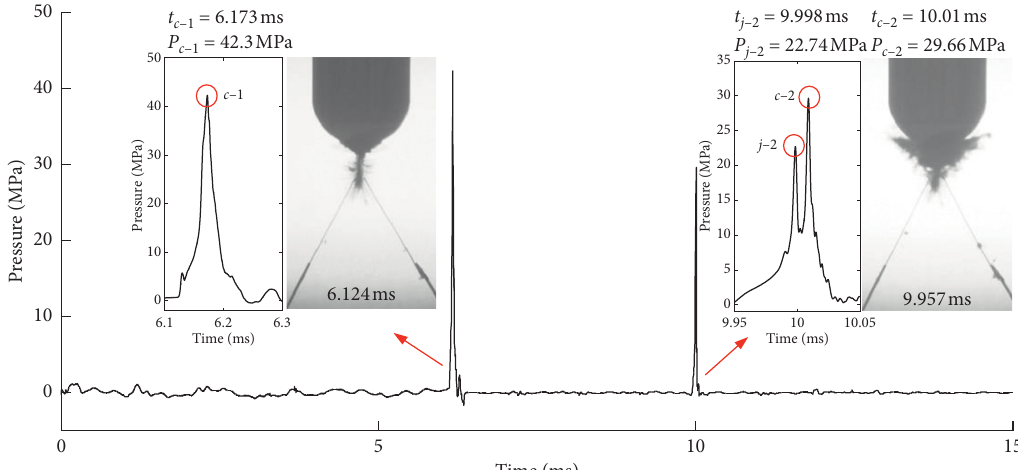
Figure 17: Pressure-time diagram of the first and second cycles of the electric-spark-generated bubble load for c � 0.67.